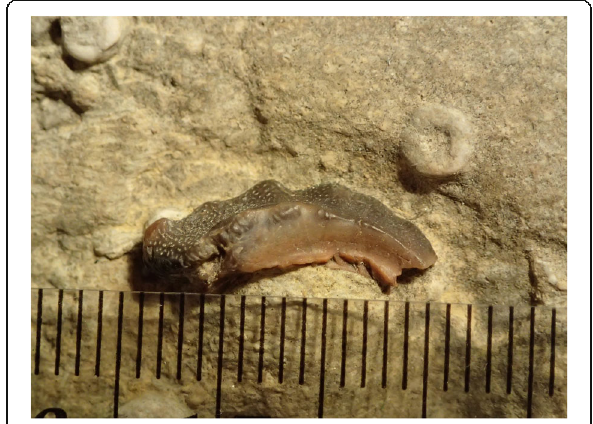
Fig. 8 Lateral view of holotype of Arcuodus multicuspidatus, Itano and Lambert, gen. et sp. nov., ALMNH PV 2016.0002.0002, prior to extraction from the matrix. Millimeter scale